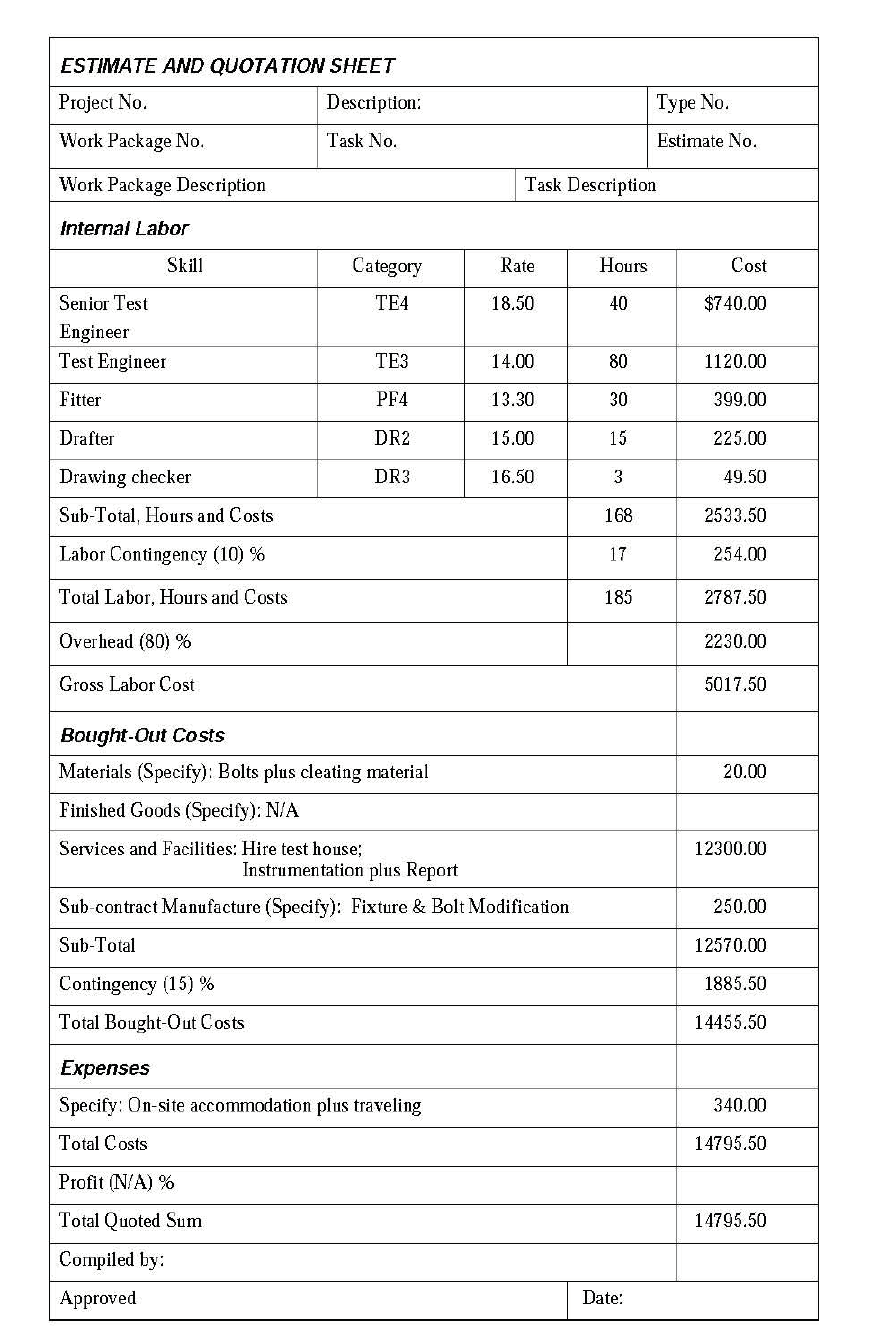
Fig. 10. Project activity cost estimating sheet (Venkataraman & Pinto, 2008: